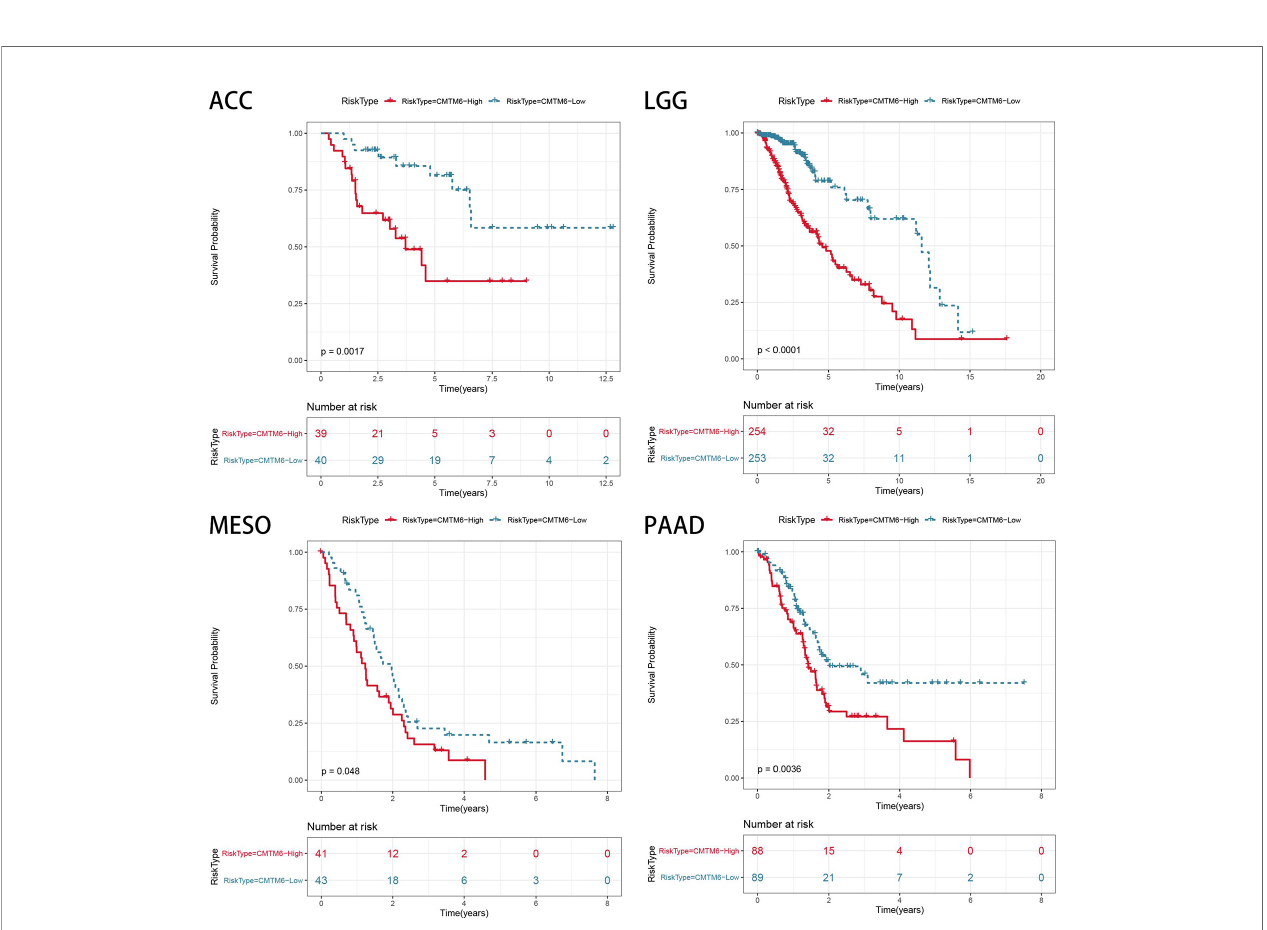
FIGURE 7 | Association of CMTM6 expression with patient overall survival in pan-cancer. High expression of CMTM6 predicts poor overall survival (OS) of adrenocortical carcinoma (ACC), lower grade glioma (LGG), mesothelioma (MESO), and pancreatic adenocarcinoma (PAAD). Red color represents high CMTM6 expression and blue color represents low CMTM6